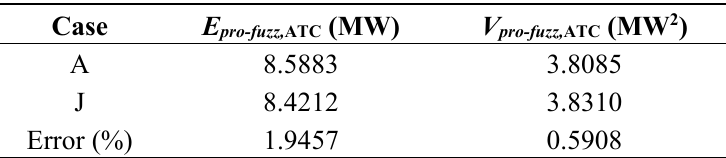
Table 6. The results of Case A and Case J.